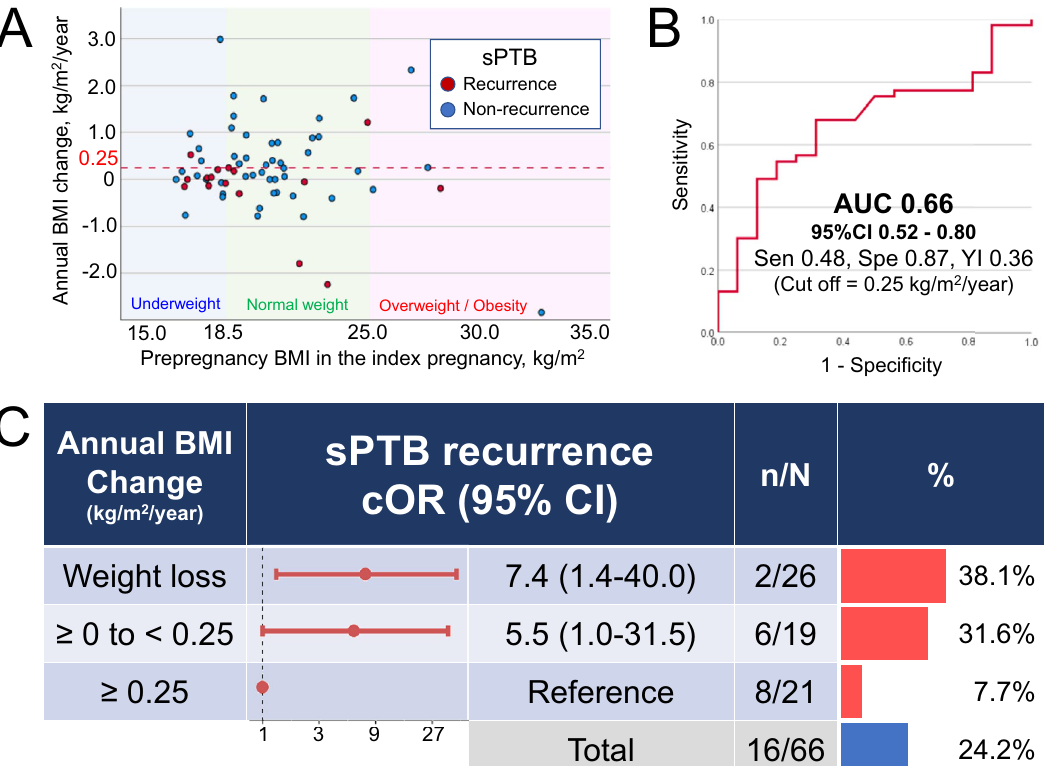
Figure 2. Association between annual BMI change during the interpregnancy interval and recurrent sPTB among individuals with a history of sPTB. ( A ) Pre-pregnancy BMI in the index pregnancy and annual BMI change. Red and blue dots indicate values in the sPTB recurrence group and non-recurrence group, respectively. Red dash line indicates an annual BMI change of 0.25 kg/m 2 /year. ( B ) Receiver operating characteristic curve of the annual BMI change for the development of sPTB recurrence in the subsequent pregnancy. ( C ) Crude odds ratios for recurrent sPTB with 95% CI in each category of annual BMI change, with an annual BMI change of ≥ 0.25 kg/m 2 /year as the reference. The right-sided graph shows the sPTB recurrence in each category of annual BMI change. The number of recurrent sPTBs/total number is also shown as n/N. BMI, body mass index; AUC, area under the curve; Sen, sensitivity; Spe, specificity; YI, Youden index; sPTB, spontaneous preterm birth; cOR, crude odds ratio; CI confidence interval.